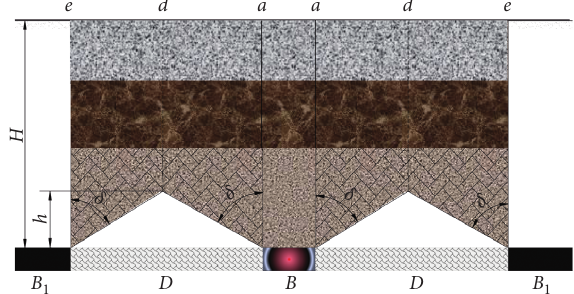
Figure 6: Diagram of coal pillar load